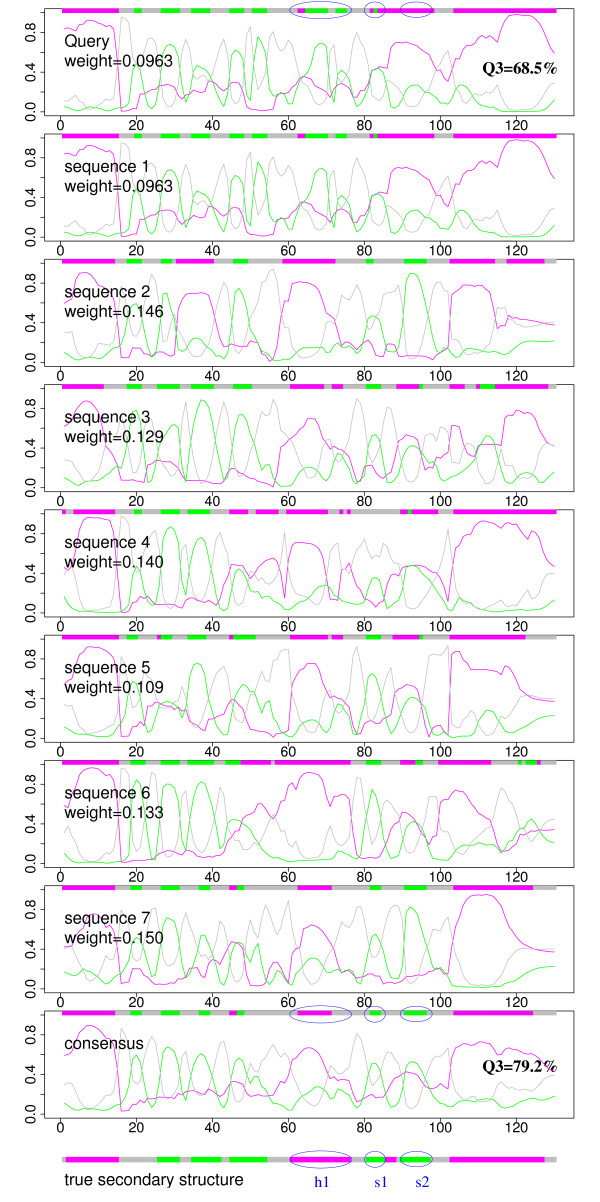
Example of a multiple sequence prediction for d1jyoa_. Each plot represents the posterior probabilities of α-helix, β-strand and coil as a function of the position in the sequence, with the color scheme : magenta = helix, green = strand, grey = coil. "Query" indicates the sequence of the initial sequence d1jyoa_ and "sequence 1" to "sequence 7" are the homologuous sequences retrieved by PSI-BLAST. The Henikoff weight of each sequence is indicated on each plot. "Consensus" indicate the consensus prediction for the sequence family. The predicted secondary structure in each case is shown as a colored bar in the upper part of each plot. The observed secondary structure of d1jyoa_ is plotted in the lower part of the figure. Ellipses focus on zones of the secondary structures that are modified in the prediction using only the query sequence and in the prediction using the multiple sequence alignment.